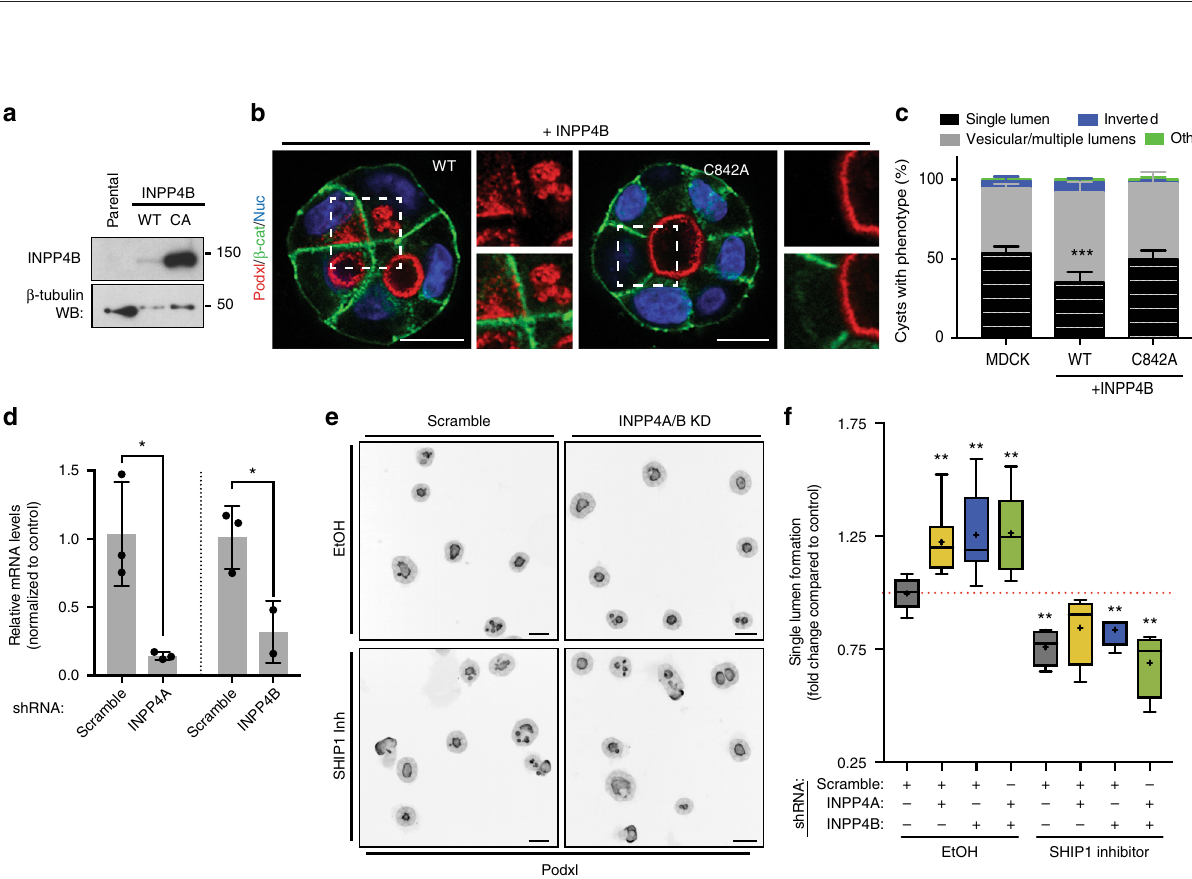
Fig. 6 Class-II PI3-kinases regulate lumen formation. a Downregulation of PIK3C2A , PIK3C2B and PIK3C2G by shRNA. RNA extracts from MDCK cells stably expressing scramble or shRNA targeting the corresponding gene were analyzed by RT-qPCR. Mean± s.d., n = 3 wells/condition, from one experiment. P- values: One-way ANOVA. * P ≤ 0.05, *** P ≤ 0.0001. b , c Quantitation of single lumen formation in cysts (48h) stably expressing either scramble or PIK3C2A/B/G shRNAs alone or in combination b and representative images of Podxl staining from these condition ( c , Podxl in inverted greyscale; scale bars, 50 µ m). Values are fold change to control. Box-and-whiskers: 10 – 90 percentile; + , mean; dots, outliers; midline, median; boundaries, quartiles. n ≥ 1900 cysts assessed from three replicate wells/condition/experiment, from two independent experiments. P- values: One-way ANOVA. * P ≤ 0.05, ** P ≤ 0.005, *** P ≤ 0.0005. d – f MDCK cysts stably expressing GFP-PIK3C2A or GFP-PIK3C2B (green), stained for Rab11a (red) at indicated polarity stages. Magenta arrowheads, PIK3C2A/B overlapping with Rab11a vesicles. Yellow arrows, Rab11a-negative, PIK3C2A/B punctate localization. White arrowheads, basolateral PIK3C2B. White arrows, Rab11 positive vesicles. Scale bars, 10 µ m. g Quantitation of polarity phenotypes in control (EtOH) or SHIP1 inhibitor-treated (SHIP1- i) parental (MDCK) cysts, or stably expressing GFP-PIK3C2A or GFP-PIK3C2B. Box-and-whiskers: 10 – 90 percentile; + , mean; midline, median; boundaries, quartiles. PIK3C2A, n ≥ 1550 cysts assessed from three replicate wells/condition/experiment, two independent experiments. P- values, Mann – Whitney test: * P ≤ 0.05, ** P ≤ 0.005. PIK3C2B, n ≥ 800 cysts assessed from 2 to 3 replicate wells/condition/experiment, three